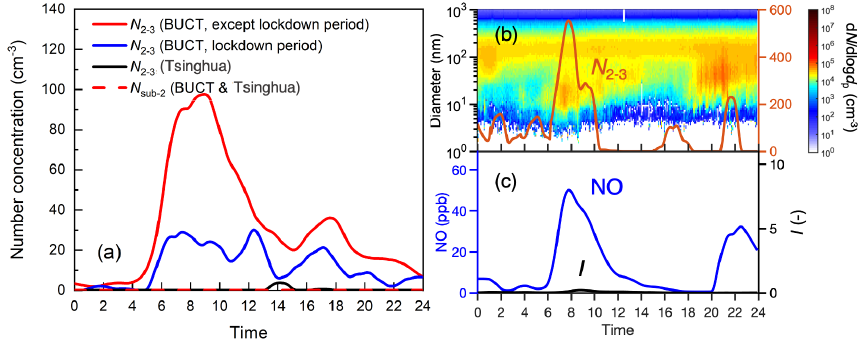
Figure 6. (a) Median diurnal variations of number concentrations of 2–3nm aerosols ( N 2 − 3 ) on non-NPF days at the BUCT site during COVID-19 lockdown period (14 January–25 February 2020) and other time period (except lockdown period), and at the Tsinghua site (7 March 2016–6 April 2016). The median diurnal variations of number concentrations of sub-2nm aerosols ( N sub-2 ) are near zero on non- NPF days at both BUCT and Tsinghua sites. The temporal pattern of (b) aerosol size distributions, N 2 − 3 , (c) NO concentration, and the indicator I on a non-NPF day (13 March